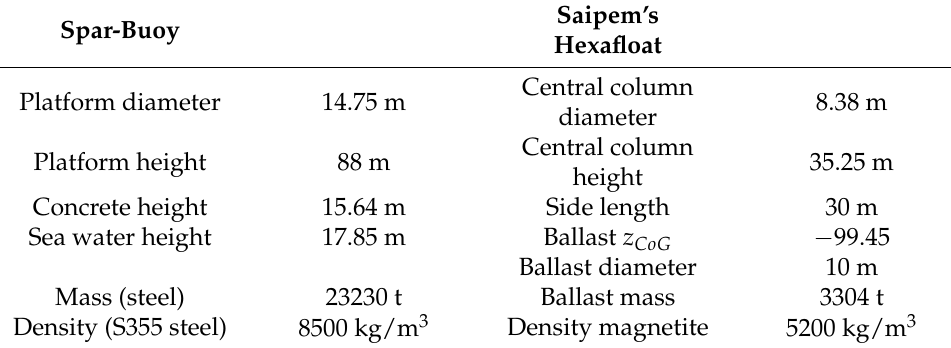
Figure 15. Spar-buoy on the left, Saipem’s hexafloat on the right. Table 5. Floaters